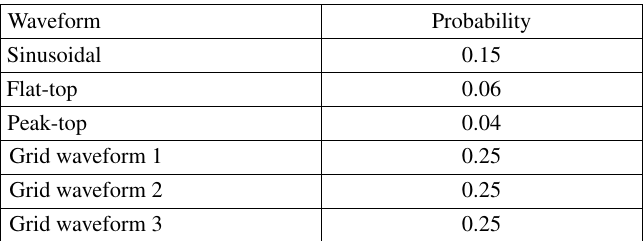
Table 1. Waveform probability used in the model